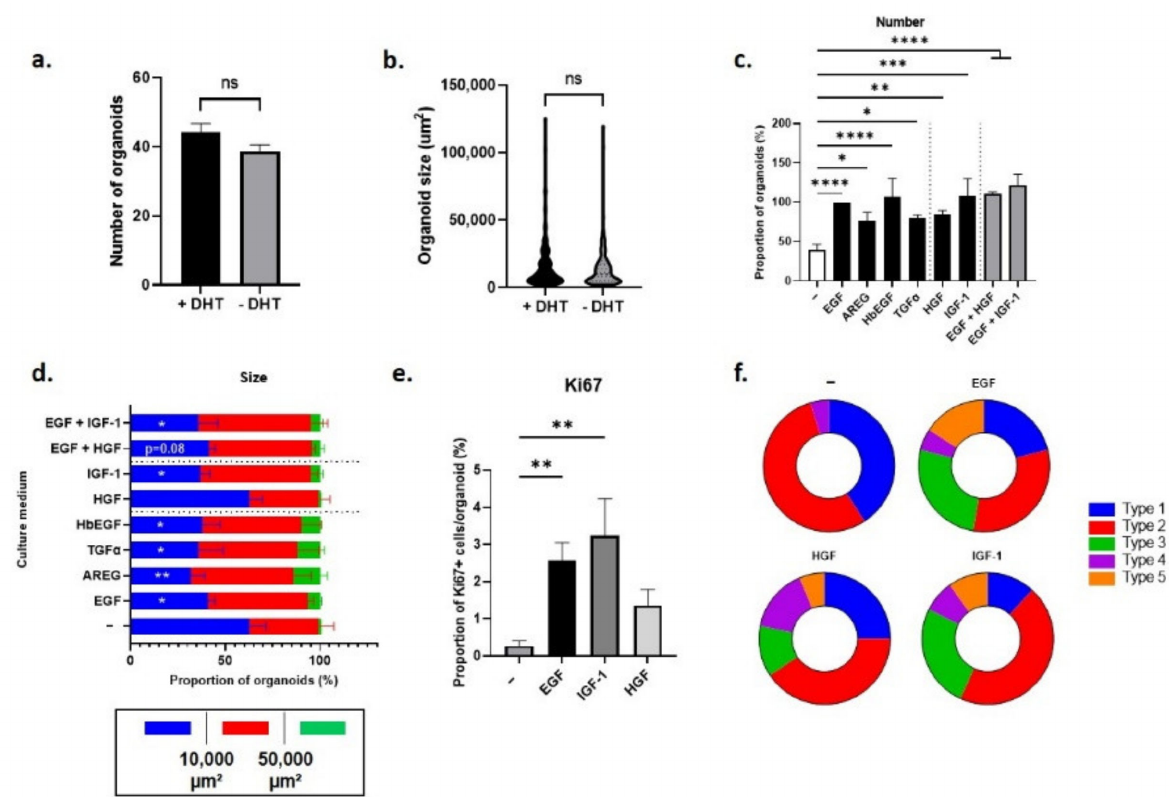
Figure 7. Impact of EGFR/ERBB4, MET and IGF-1R ligands on the number, size, cell proliferation and type of organoids generated from Pten-null LSC med cells in DHT-containing medium. ( a , b ) Effect of DHT (1 nM) on the number ( a ) and size ( b ) of organoids generated by LSC med cells FACS- enriched from Pten -null mouse prostates. ( c , d ) Effect of various growth factors substituted for, or combined to, EGF (as indicated) on the number ( c ) and size ( d ) of organoids measured at day 10 of culture. Organoid size is color-coded as follows: smaller than 10,000 µ m 2 (blue), between 10,000 and 50,000 µ m 2 (red), and higher than 50,000 µ m 2 (green). ( e ) The effect of various growth factors (as indicated) on cell proliferation in organoids was determined at day 10 by KI-67 IF analysis. ( f ) Schematic representation of the different types of organoids (described in Figure 6) that were generated in the presence of various growth factors (as indicated). See Table S2 for the concentrations of growth factors added to the culture medium. Data were obtained from 3 independent experiments each involving 1 or 2 animals. Statistical analyses were performed using t-test ( a , b ), one-way ANOVA followed by Dunnett’s post hoc test ( c , e ) or two-way ANOVA ( d ). * p < 0.05; ** p < 0.01; *** p <